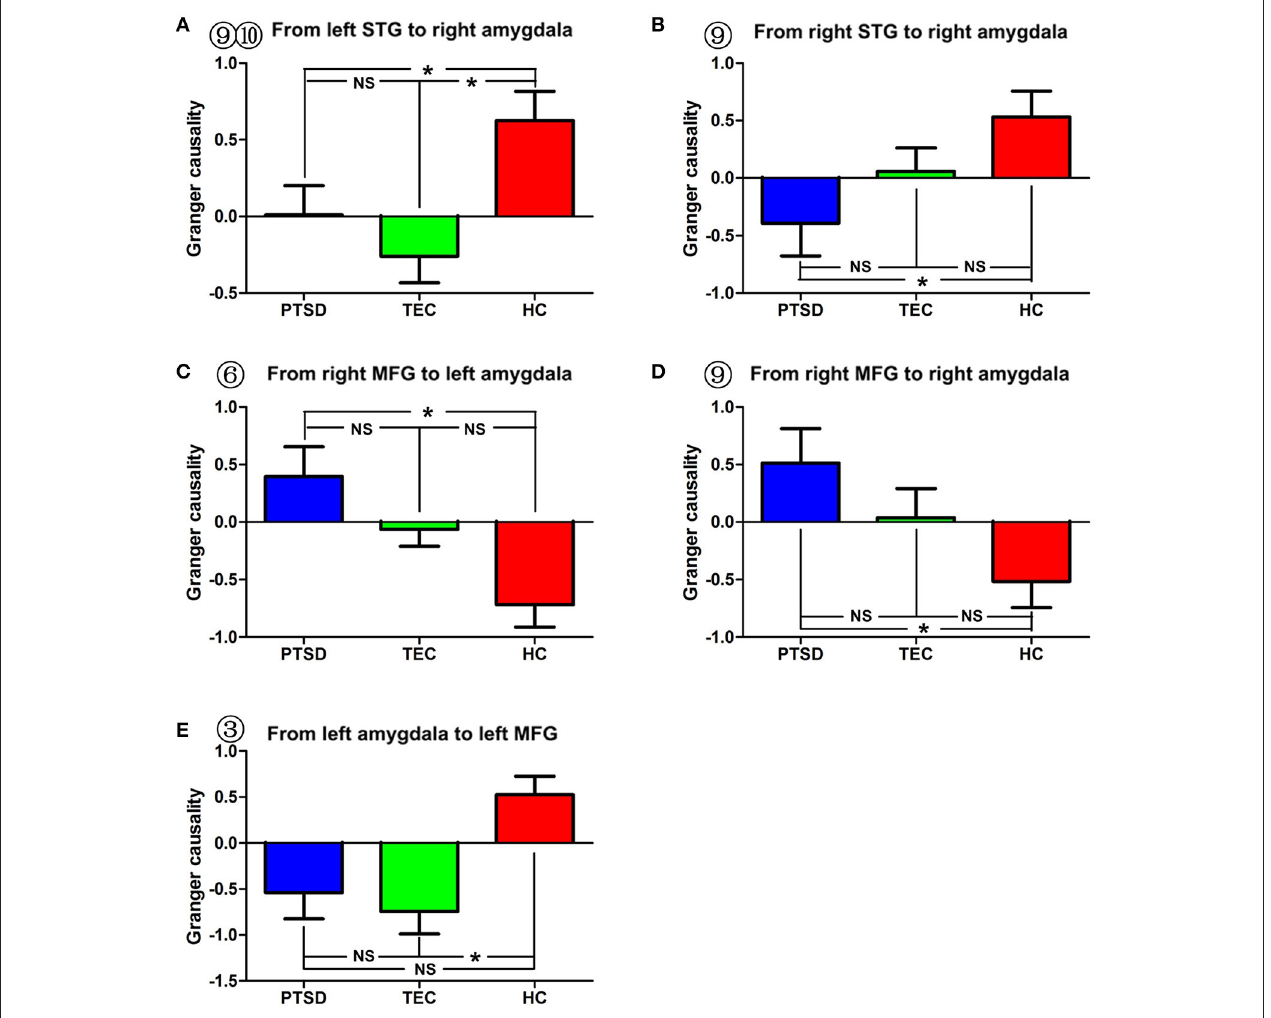
FIGURE 3 | Comparison of effective connectivity between the amygdala and the bilateral superior temporal gyrus and between the amygdala and the middle temporal gyrus. (A,B) show inter-group differences regarding the influence of the superior temporal gyrus on the right amygdala. (C–E) show inter-group differences regarding the influence of the middle frontal gyrus on the amygdala and the influence of the amygdala on the middle frontal gyrus. PTSD, post-traumatic stress disorder group; TEC, trauma-exposed control group; HC, healthy control group; SFG, superior frontal gyrus; MFG, middle frontal gyrus. “*” means having significant difference between the two groups.